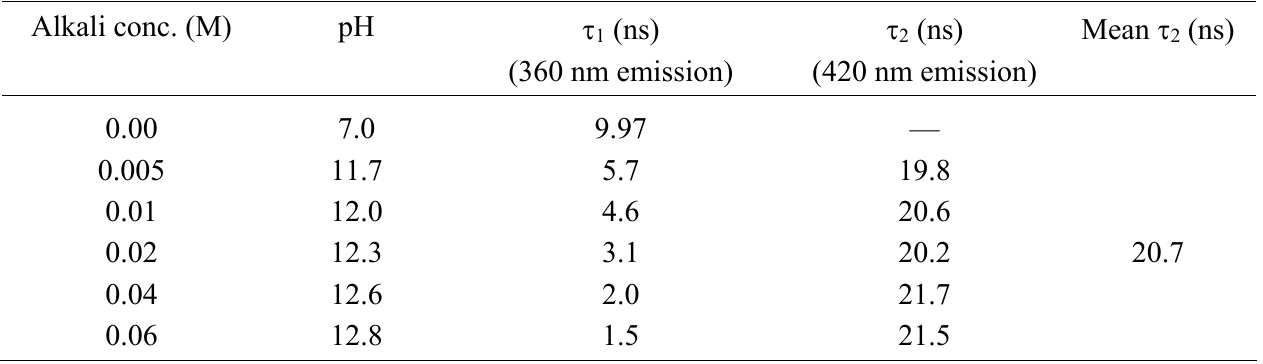
Table 2. Fluorescence decay parameters of CAZL at different pH. Alkali conc. (M)